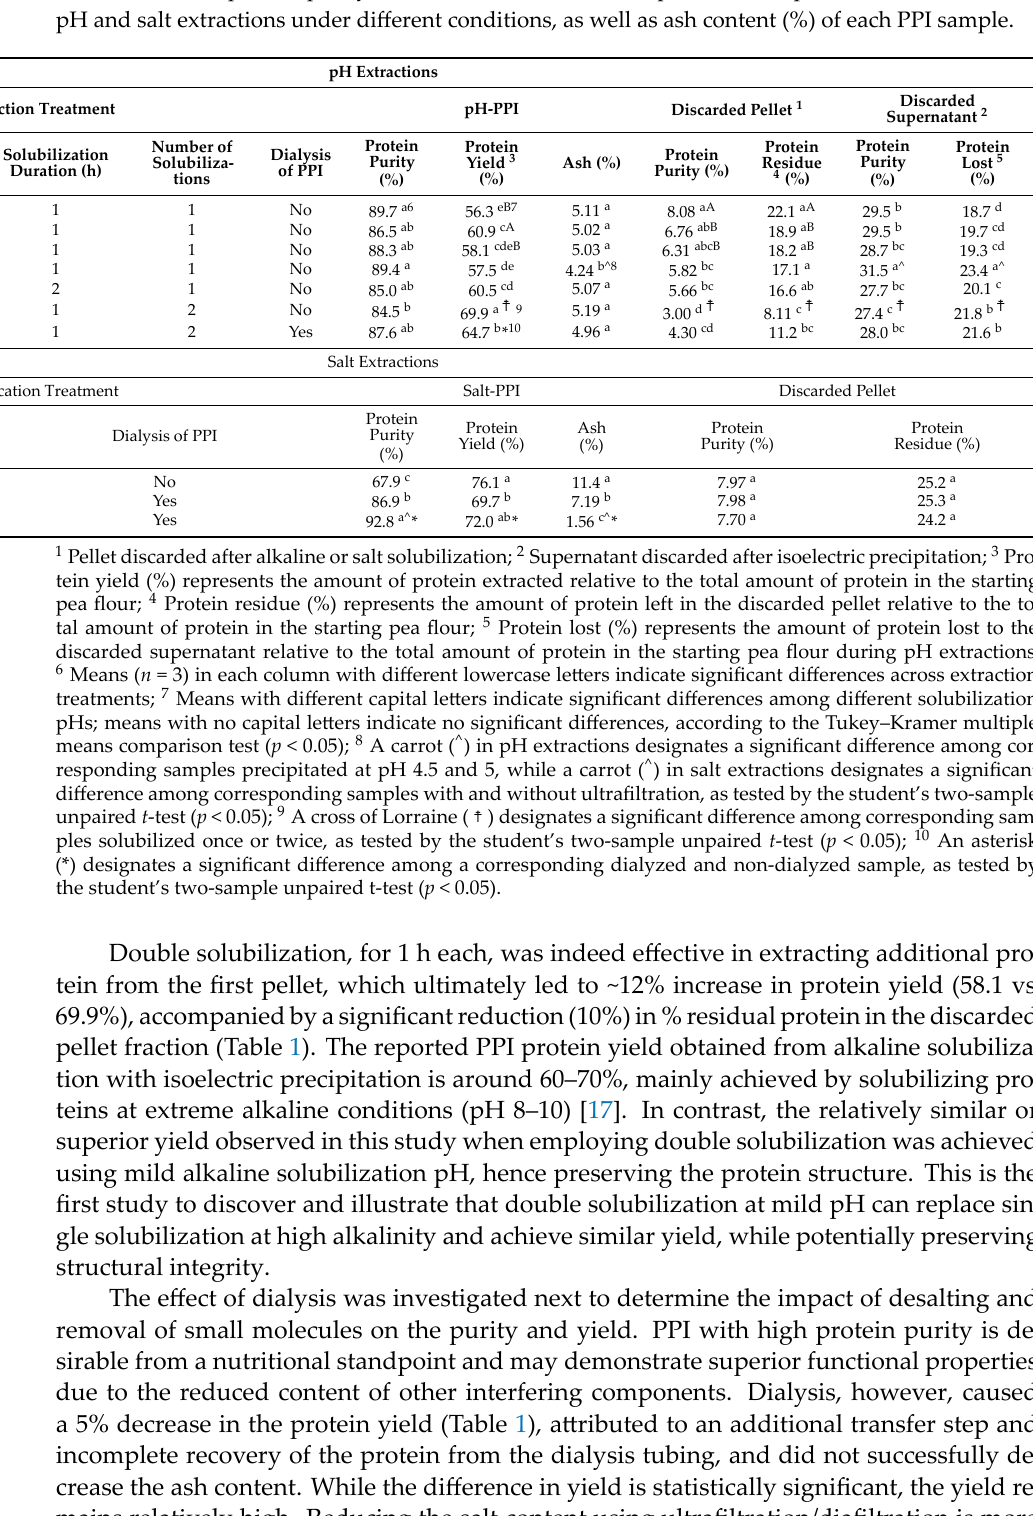
Table 1. Percent protein purity and distribution in the PPI, pellet, and supernatant fractions from pH and salt extractions under different conditions, as well as ash content (%) of each PPI sample.